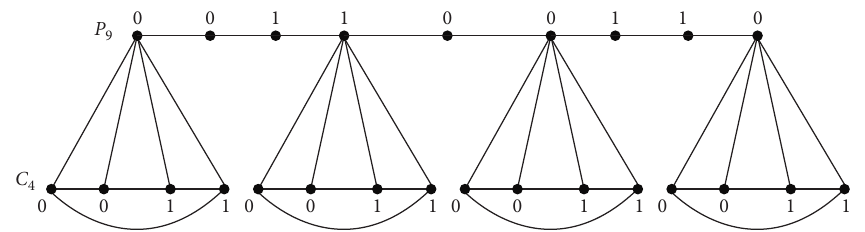
Figure 7: Logical labeling of P